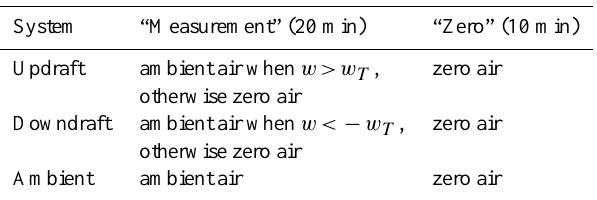
Fig. 2. A schematic diagram of a REA HONO flux measurement setup, consisting of a 3-D sonic anemometer to measure vertical wind, a Na 2 CO 3 -coated annular denuder to generate “zero-HONO” air, and two LPAP systems to measure HONO concentrations in the up- and down-draft air. A computer acquires and processes 3-D wind data, and controls the REA valves based on the vertical wind information. Table 1. Sampling status in the three HONO measurement systems in a 30-min